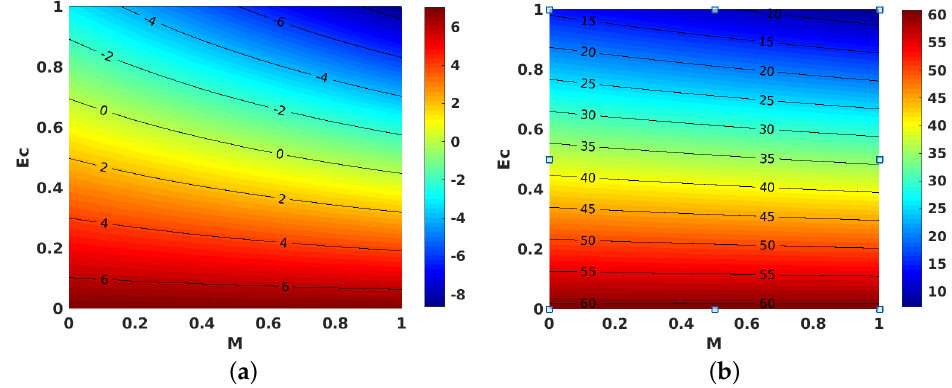
Figure 11. Effect of Eckert number ( Ec ) and magnetic parameter ( M ) on θ (cid:48) ( 1 ) . ( a )